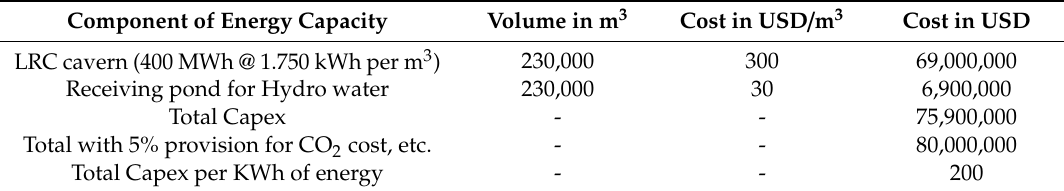
Table 1. Capex of Energy Capacity for the UPHES